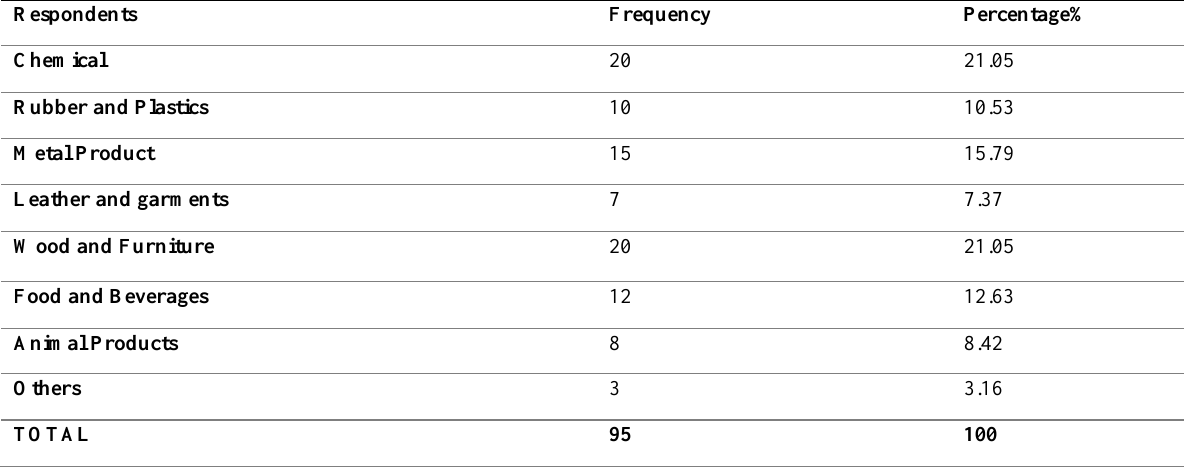
Table 2: Analysis based on Nature of Business